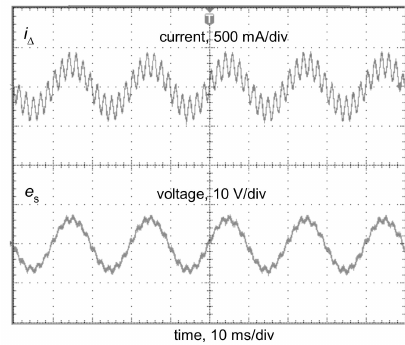
Figure 3. Oscillogram of the induced secondary voltage e s in the secondary winding of the current sensor from a 300 mA A-type RCD for the residual current i ∆ composed of the fundamental (50 Hz) and 50% content of the 11 th